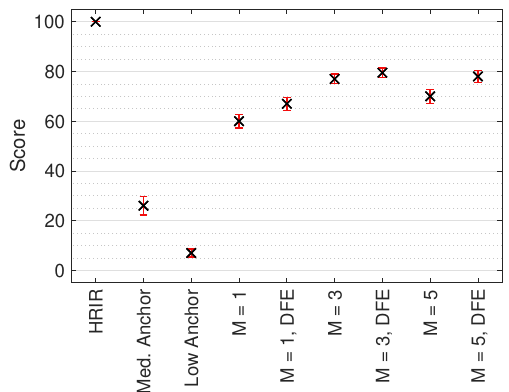
Figure 8. Median MUSHRA results with non-parametric 95% CI across all test sound locations. Score indicates perceived timbral similarity between test stimulus and HRIR